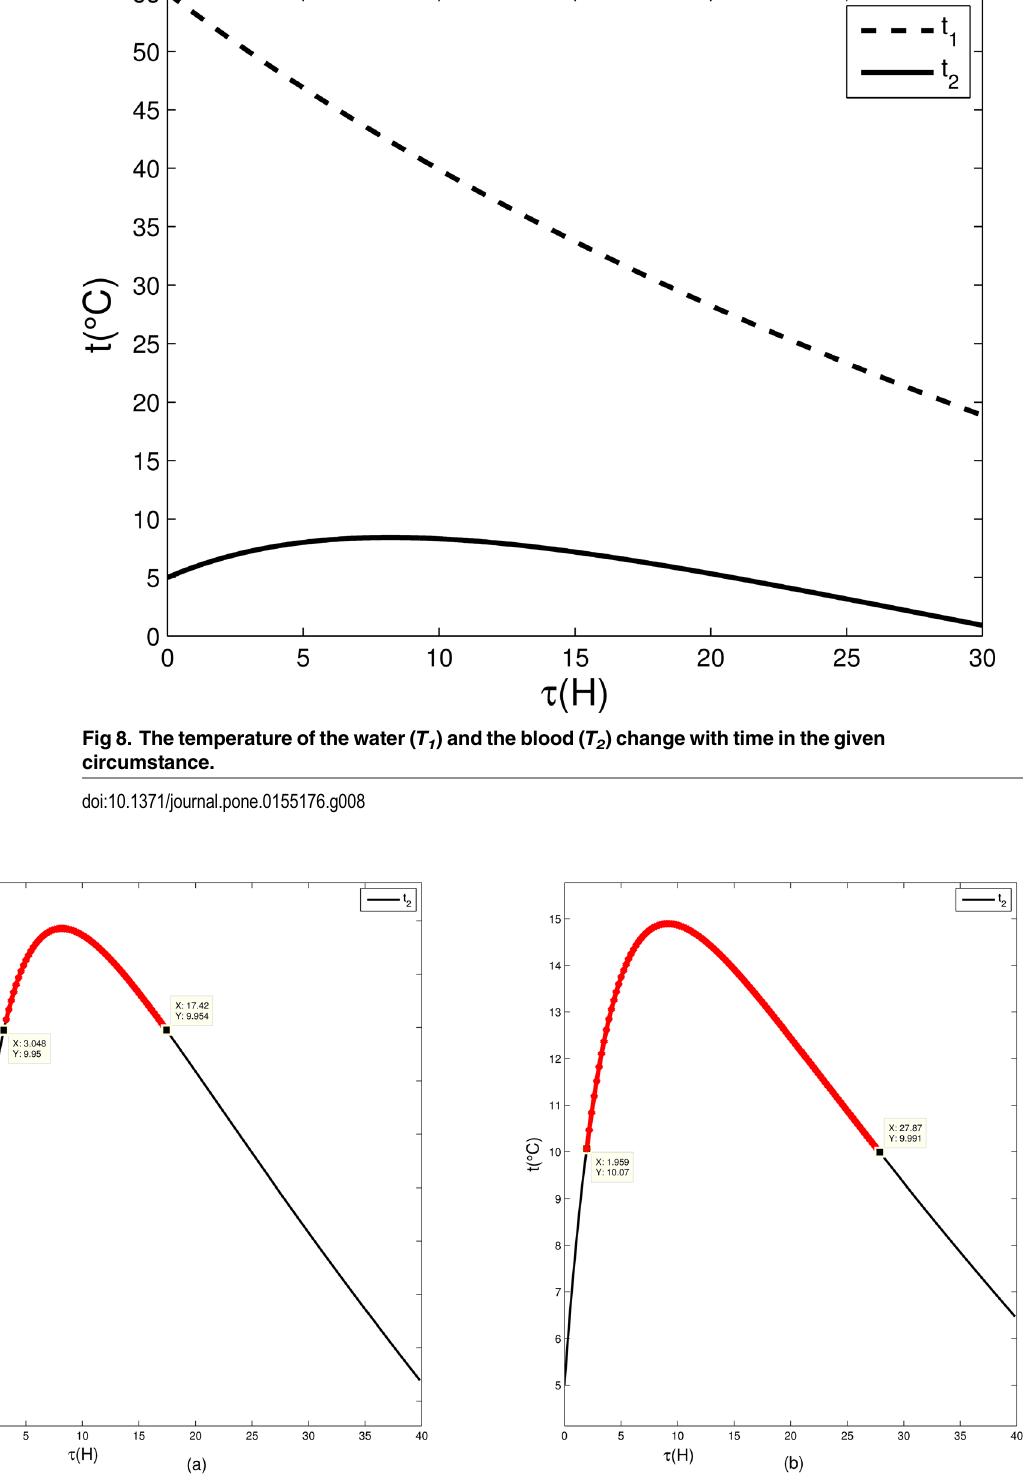
Fig 9. Temperature changes with time in the case of different weight of hot water and blood. Note: Red line represents the blood temperature is beyond the appropriate